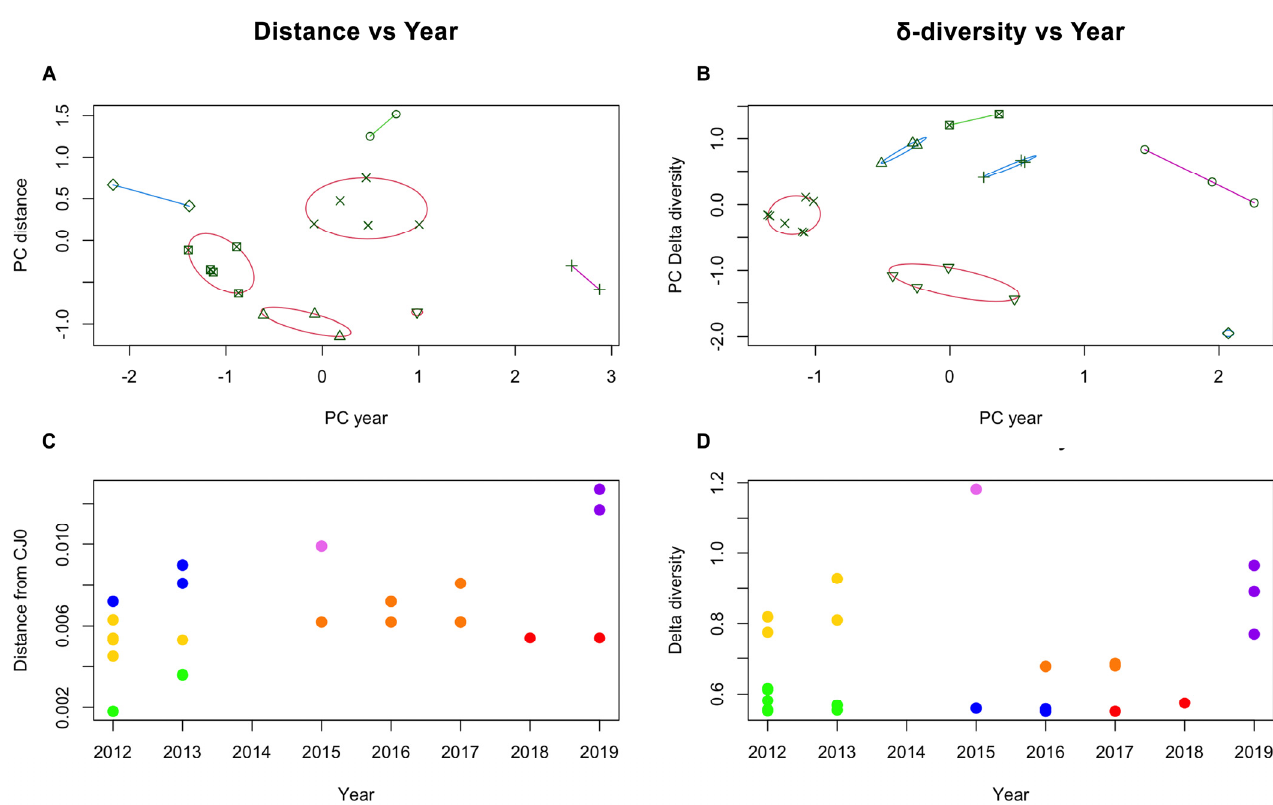
Figure 6. K-means analysis of sample clustering, based on either consensus distances ( A , C ) or δ - diversity values ( B , D ). Principal Component (PC) analysis indicates clustering according to year of isolation, and best separation was achieved when K = 7 for both datasets. Groups are separated on the PC graphs ( A , B ), and identified by colour code in the year vs. distance graphs ( C , D ). While the distribution of each isolate among groups is not equivalent for the two datasets, a similar dependence on year of isolation suggests a temporal replacement pattern of different isolate groups.